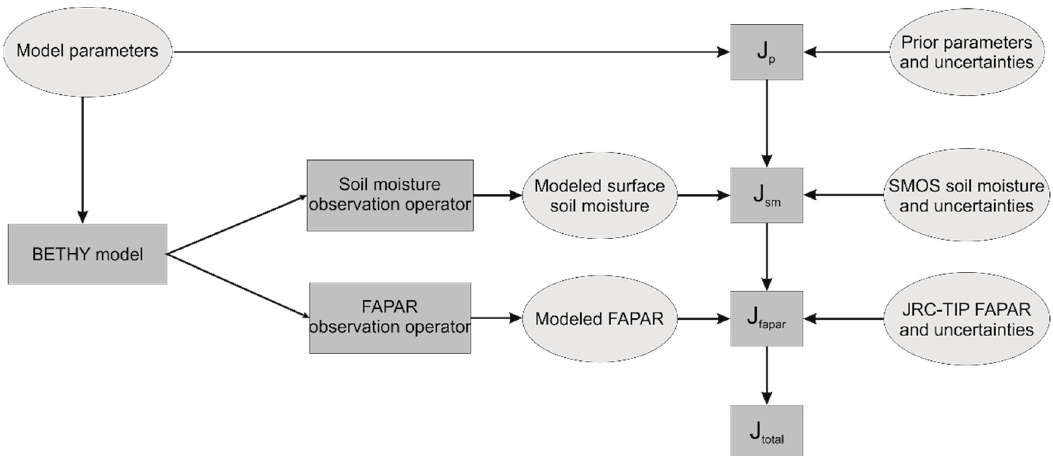
Figure 1. Flow chart of the calculation of the total cost function, J total (= J p + J sm + J fapar ) for simultaneous assimilation of soil moisture and FAPAR data as the sum of contributions from the parameter part ( J p ) and for the two data terms, J sm and J fapar . Ovals denote data and rectangular boxes denote processes (i.e., code modules).